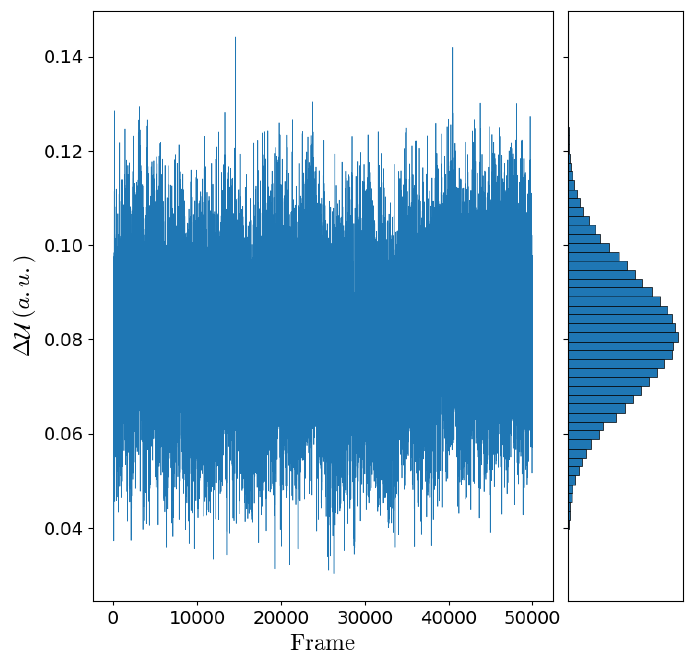
Figure 5. Trajectory and distribution of the electronic transition energies along the MD simulation and its Gaussian behaviour for the ds-5 (cid:48) -d(AAAAAAG 1 AG 2 TG 3 AG 4 A)-3 (cid:48) system. Table 2. Comparison between the calculated kinetic constant K R rate constant K CT for the intrastrand charge transfer of the G . + containing substrates. For all the calculated K R estimated kinetic